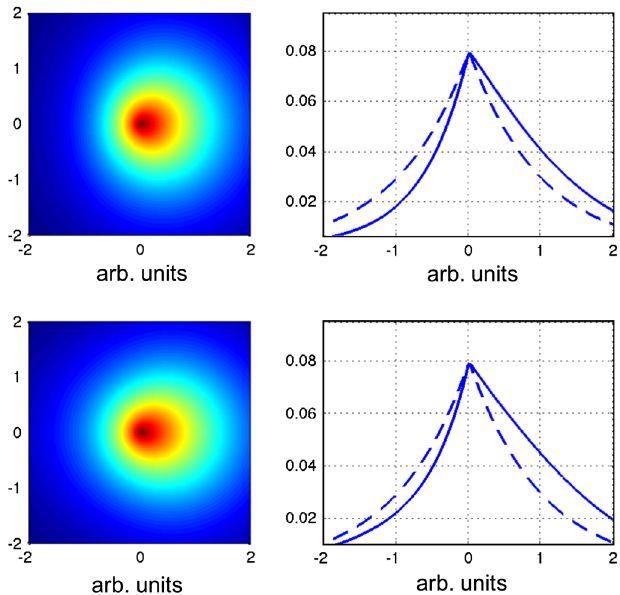
FIG. 5. Polarized screening clouds. Comparisons between the perturbed and unperturbed electron densities. On the left, we plot r Þ in the ( x , z ) plane, where Eq. (49) is used for a color map of rn e ð the top row and Eq. (C17) is shown in the bottom row. On the right, we have plotted these same quantities as cross sections along the z axis, with the perturbed density shown as a dashed curve for comparison. In each case, we have set Z (cid:3) ¼ 1 , κ i ¼ 1 , i h 1 ¼ 1 = 2 , and h 2 ¼ 1 = 4 in arbitrary units, where the coefficients h 1 are defined in Eq. (B6). ; 2